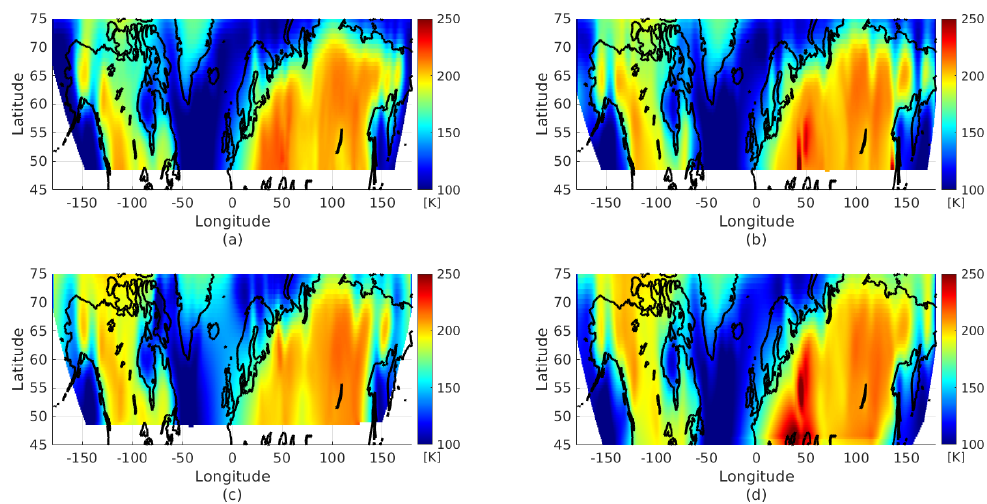
Figure 3. Flexible Microwave Payload-2 (FMPL-2) Microwave Radiometer (MWR) measurements geo-located using the Nearest Neighbor Interpolation (NNI) algorithm comprising five days of measurements with and centered on ( a ) 7 October 2020, ( b ) 21 October 2020, ( c ) 3 November 2020,